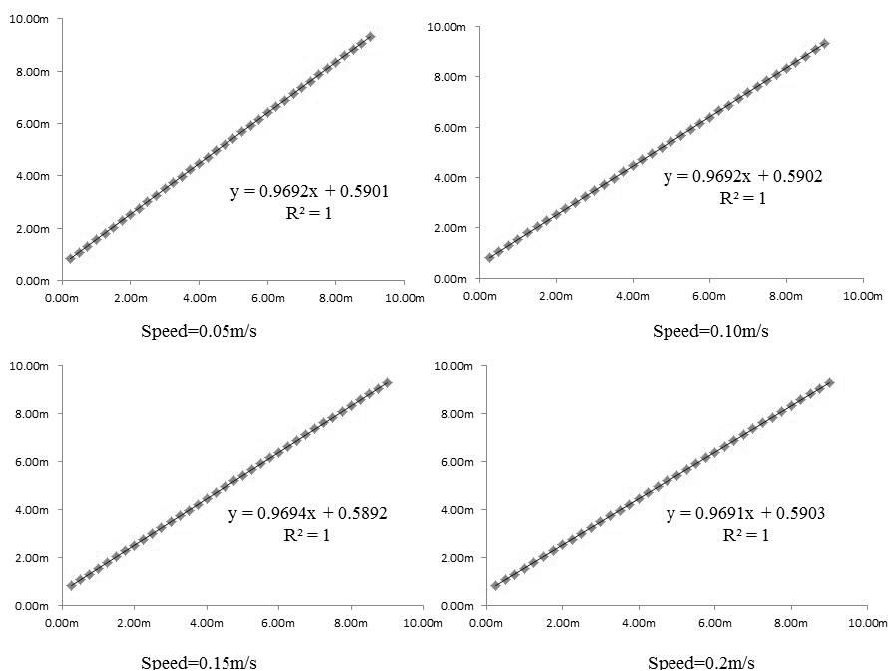
Figure 9. Horizontal direction control test results at different speeds. Figure 10. Horizontal direction control test results at different